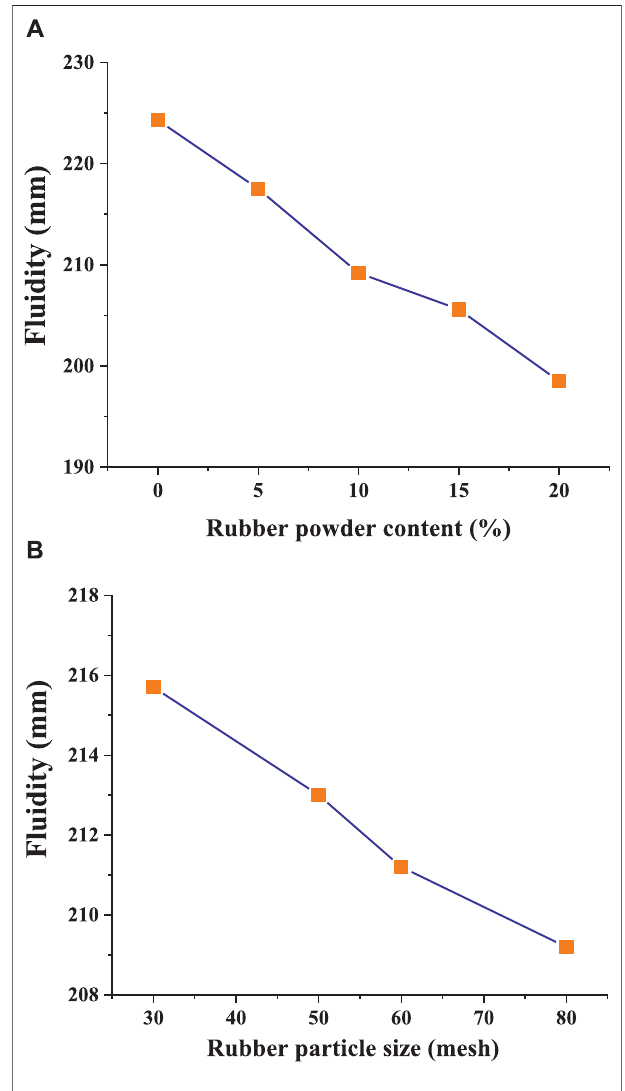
FIGURE 5 | Fluidity results of the mortar.